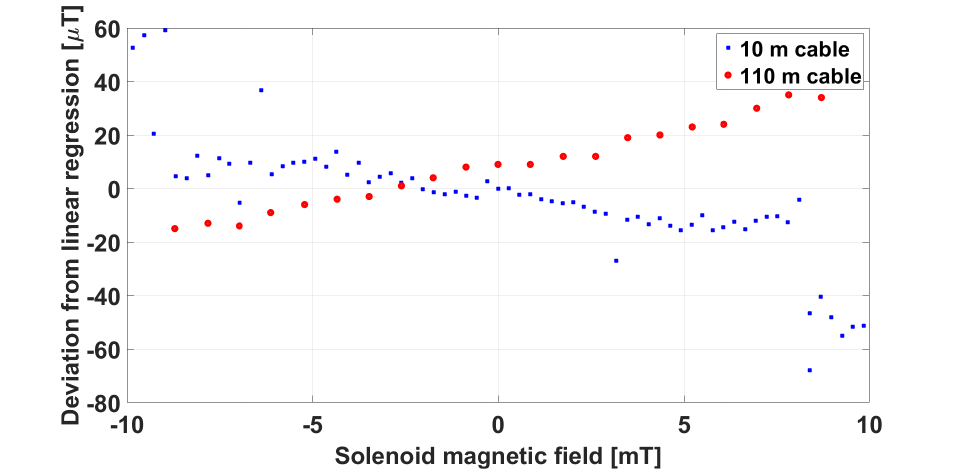
Figure 14. Comparison of linearity error carried out at Consorzio RFX at room temperature with the original 10 m cable and a 100 m test